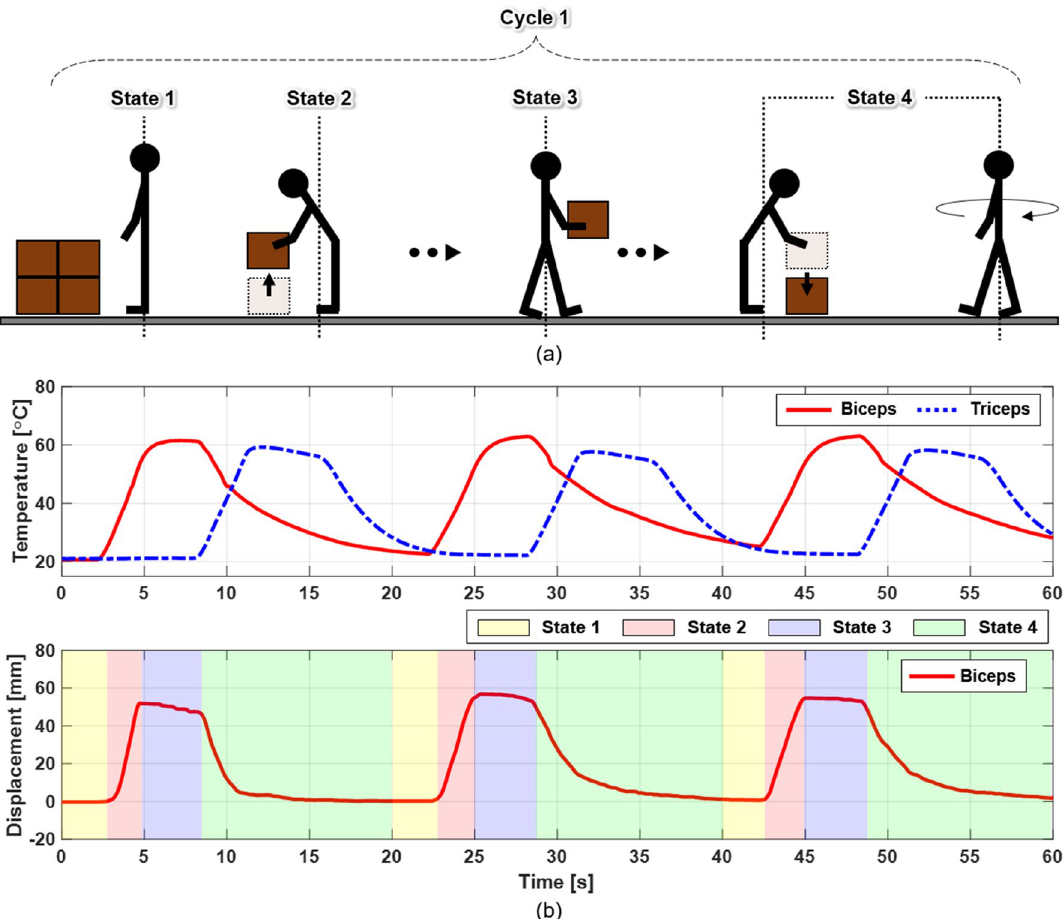
Figure 8. Example of strength-assisted task performed by person wearing exosuit applying fabric muscle (see Video S5). ( a ) The worker prepares to lift the object with both the BFM and TMF of the exosuit relaxed in a loading area (State 1: 2 s). As the worker flexes his arm and lifts the object, the BFM of the exosuit contracts to support the muscle strength (State 2: 3 s). The BFM is then controlled to a constant temperature, and the worker moves to an unloading area while maintaining the flexion state of the arm holding the object (State 3: 3 s). Finally, the worker extends his arms, lowers the object into the unloading area, and returns to the initial position (loading area) to carry the next object (State 4: 12 s). ( b ) Measured temperature (top graph) and displacement (bottom graph) of BFM and TFM according to the